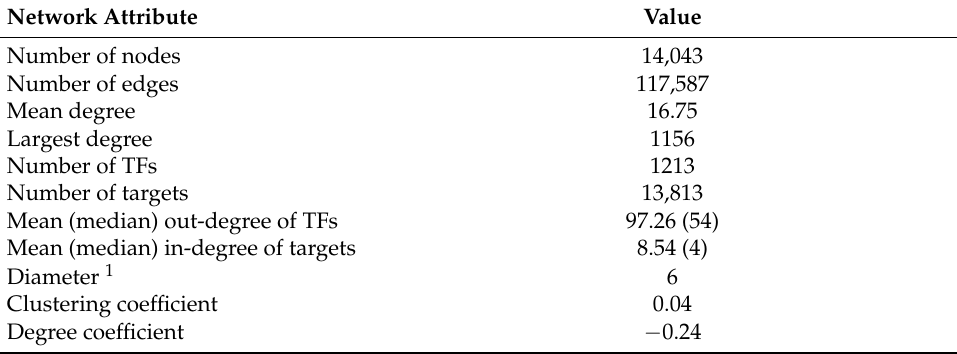
Figure 2. Parameter tuning and the degree distribution of the resultant network. ( a ) Distribution of mean R 2 from 10-fold cross-validation using a range of values for the regularization parameter λ . ( b ) Distribution of the number of predicted regulators, | in j | (top panel), and number of predicted targets, | out i | (bottom panel), with respect to the cut-off value for regression coefficient. Data points outside of two times inter-quantile range are excluded from the boxplot for clarity. Genes with no TFs predicted and TFs with no targets, collectively called singletons, are included in the boxplot. ( c ) Degree distribution of the resultant transcriptional regulatory network. Table 1. Network